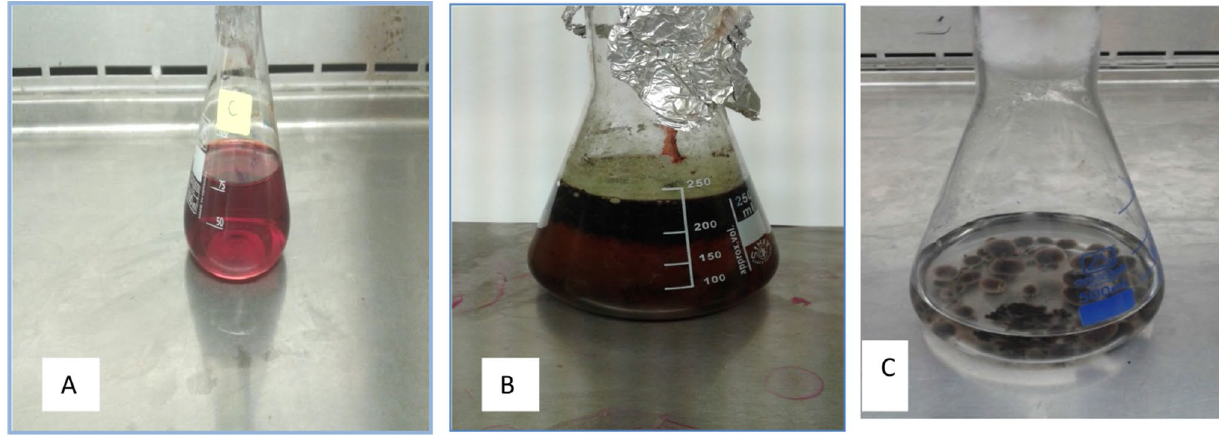
Fig. 1 Photographs of decolourization of Congo red (CR) dye. a Congo red dye (Control). b Degraded congo red dye by Aspergillusniger (MK640786). c Immobilization of decolorized fungi by sodium alginate